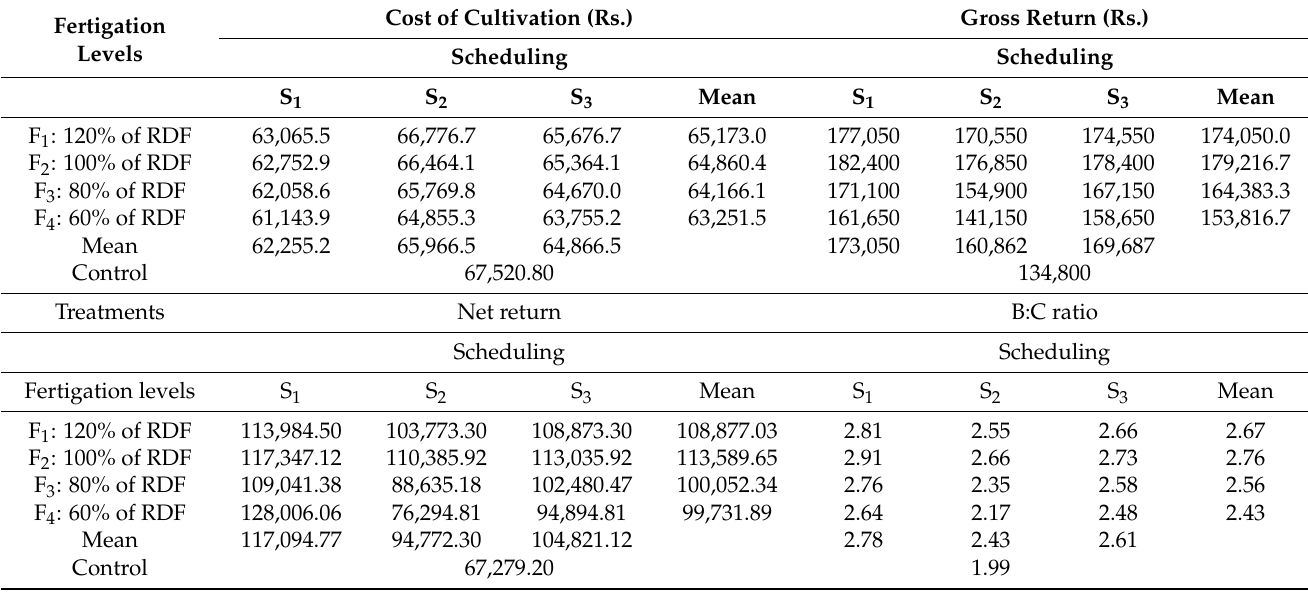
Table 11. Effect of fertigation level and scheduling on the economics of tomato cultivation (2-years pooled